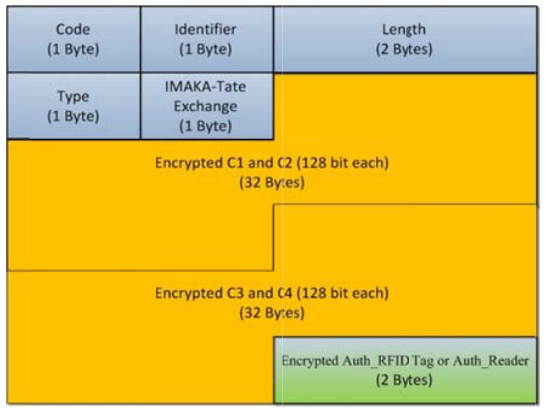
Fig. 1. Fig g. 3. EAP IMAK information. Hence, an a sitive informa ation to perfo ttacks, which a are listed as fo nformation: A An adversary reader to per ata manipul on, even it ca ITM attacks FID tags: The